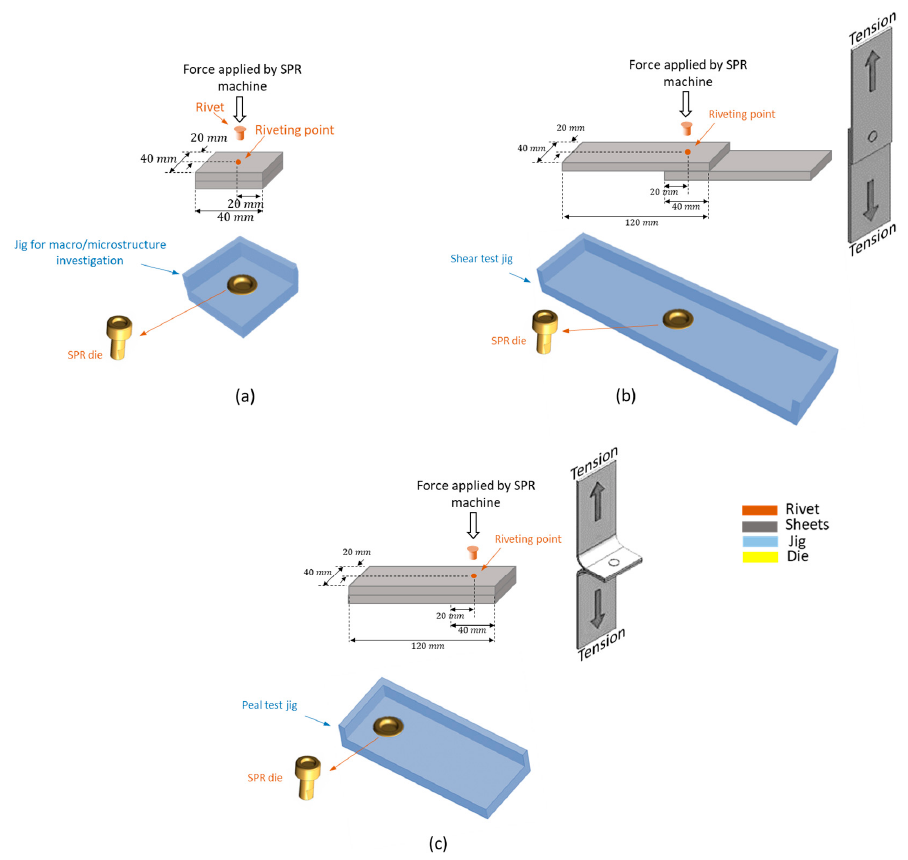
Figure 2. Schematic representation of the jigs and the stacks used to join AA6082-T6 sheets using SPR for ( a ) macro- and micro-structure investigation, ( b ) shear strength, and ( c ) peel strength tests of the joints.